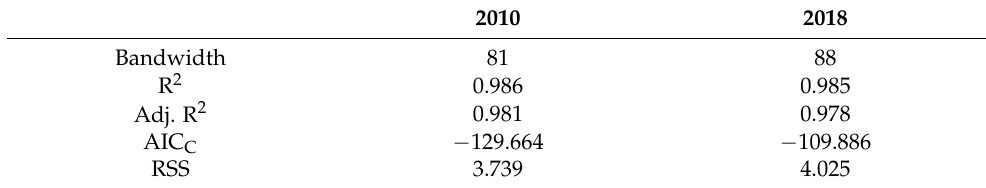
Table 6. Diagnostic information for the classical GWR model across both